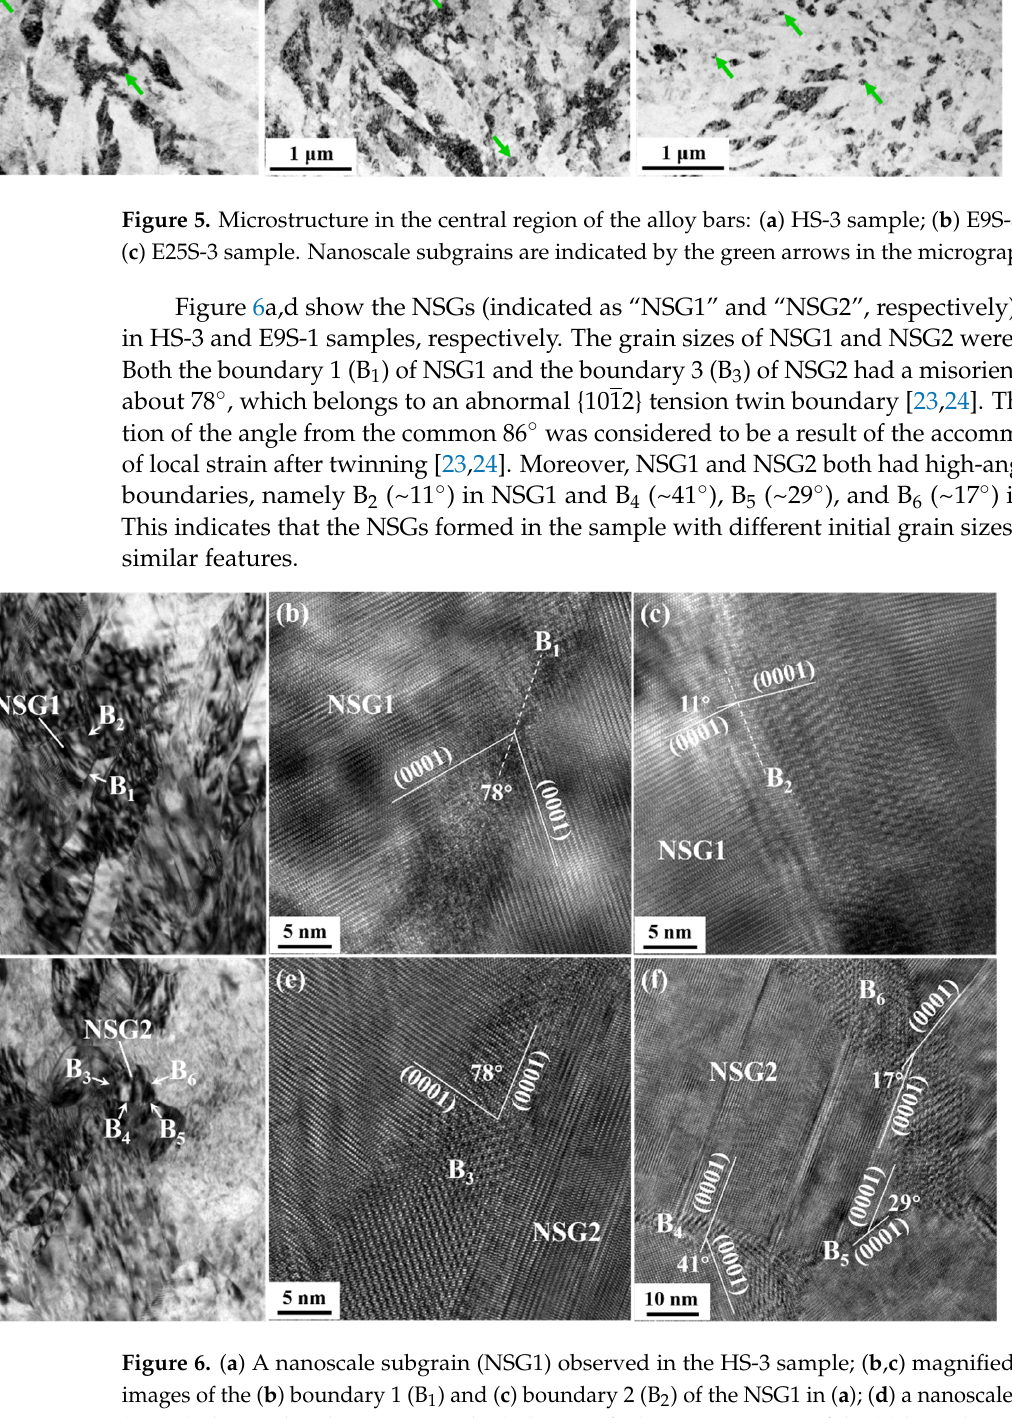
Figure 6. ( a ) A nanoscale subgrain (NSG1) observed in the HS-3 sample; ( b , c ) magnified HRTEM images of the ( b ) boundary 1 (B 1 ) and ( c ) boundary 2 (B 2 ) of the NSG1 in ( a ); ( d ) a nanoscale subgrain (NSG2) observed in the E9S-3 sample; ( e , f ) magnified HRTEM images of the ( e ) boundary 3 (B 3 ) and ( f ) boundaries 4–6 (B 4 , B 5 , B 6 ) of the NSG2 in ( d ).